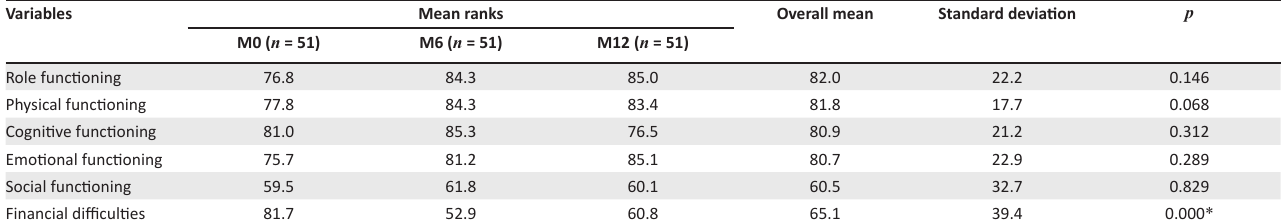
TABLE 3: Functioning and financial difficulties across the groups ( n = 153).